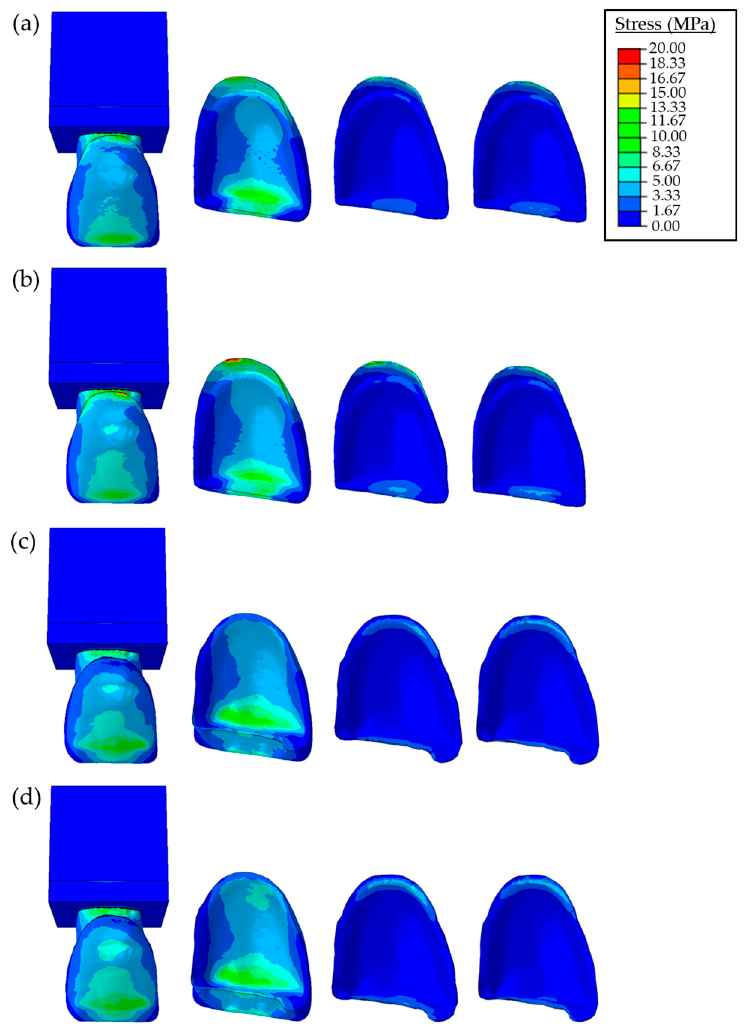
Figure 5. Stress distributions due to a horizontal force of 15 N with 90° angle in the restored teeth, porcelain laminate veneer, adhesive cement, and adhesive layer, respectively. Butt joint preparation using ( a ) low modulus, ( b ) high modulus resin cement, and palatal chamfer restoration using ( c ) low modulus and ( d ) high modulus resin cement.